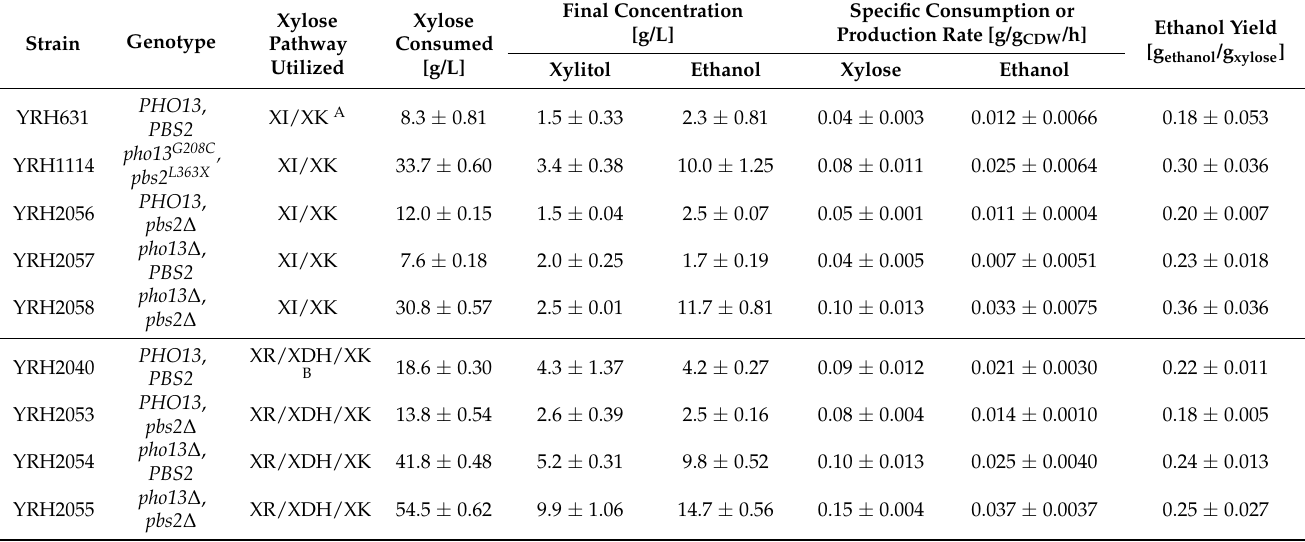
Table 5. Fermentation of xylose by strains with PBS2 and PHO13